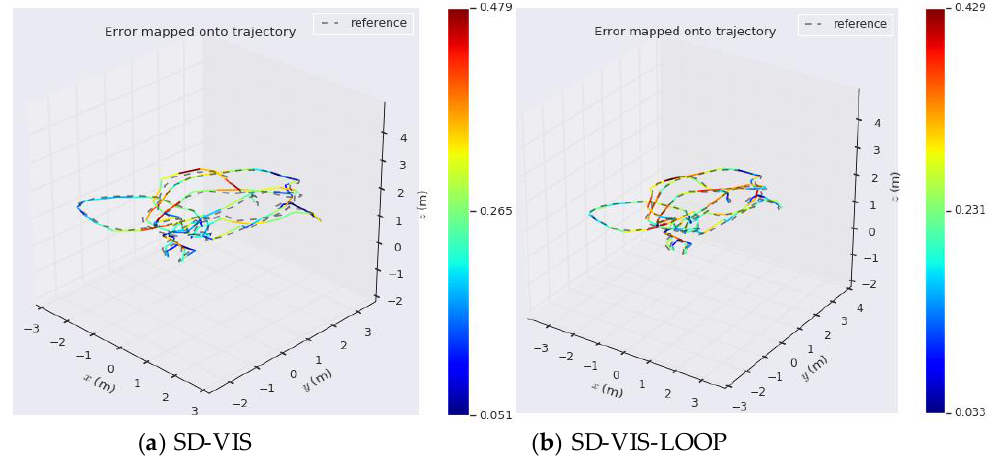
Figure 10. The trajectory heat map estimated by SD-VIS and SD-VIS-LOOP in V1_01_easy. Sensors 2020 , 20 , x FOR PEER REVIEW